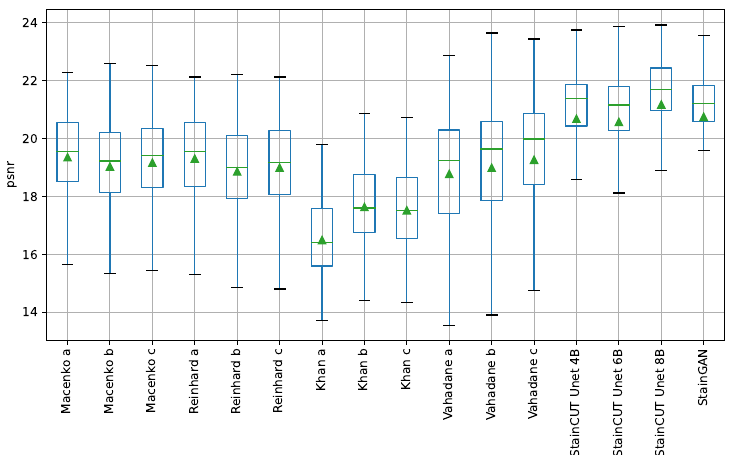
Figure A1. Boxplots of the evaluation of the PSNR metric for all compared methods on the MITOS- ATYPIA dataset. Each box is drawn from the first to the third quartile. The horizontal lines represent the median value, and the triangle represents the mean. The whiskers indicate the minimum and maximum value of the distribution.